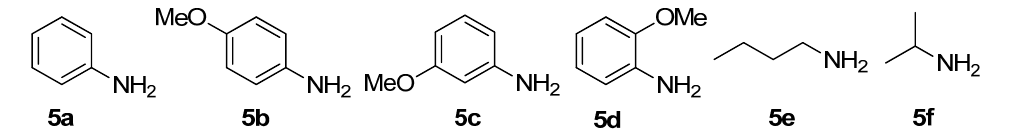
Figure 2. Diversity reagents 5 for secondary α -1,2,3-triazoloamides 1 . Figure 3. Diversity reagents 6 for 1,2,3-triazoloamides 1 and 2 .